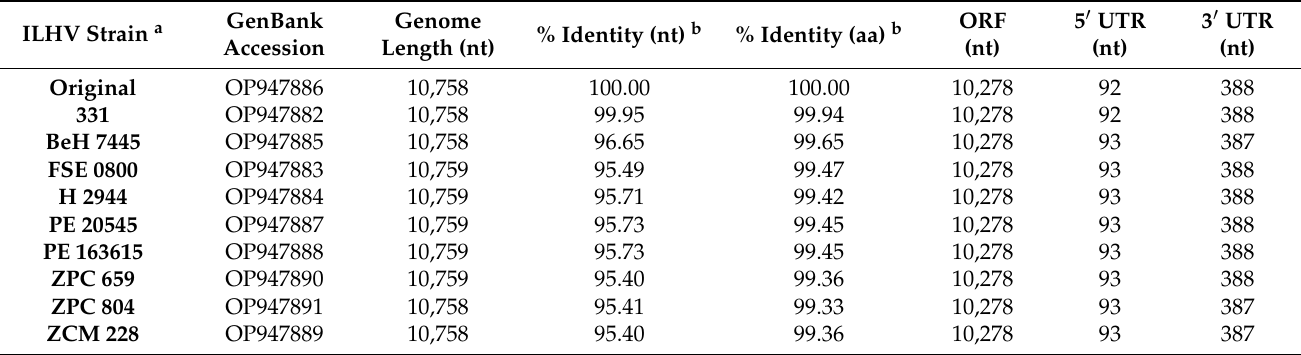
Table 2. Characterization of ILHV genetic